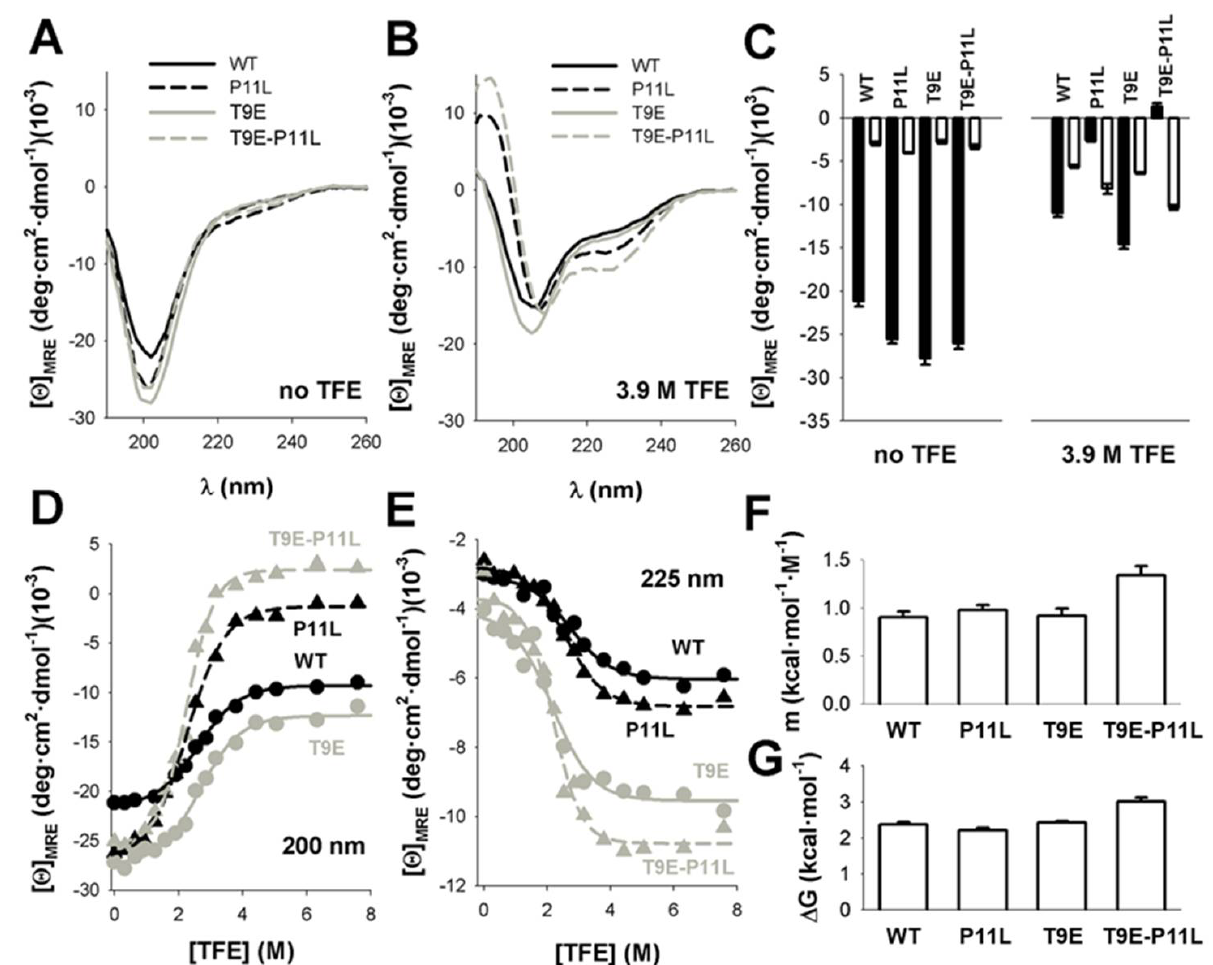
Figure 2. TFE increased ordered secondary structure in NTT − AGT peptides. ( A , B ). Far-UV CD spectra of NTT-AGT peptides in aqueous solution (no TFE) or at a high TFE concentration (3.9 M